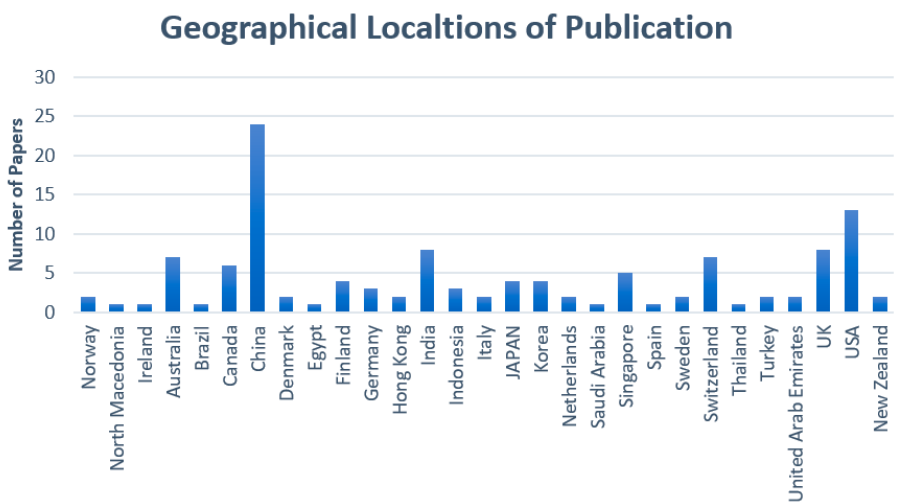
Figure 5. Figure illustrates the analysis of selected paper types in the blockchain domain. Figure 6 shows the statistics about the geographical distribution of the selected pa- pers. It is noticed that China leads with 24 articles, followed by the USA with 13 papers (published in academia or industries). Moreover, India is the 4th leading country with eight papers, and closely followed by UK, Switzerland, and Australia with eight, seven, and seven papers, respectively. Only seven countries have over five publications. The rest are below five. This analysis reflects the interest of the research community on blockchain scalability around the world.